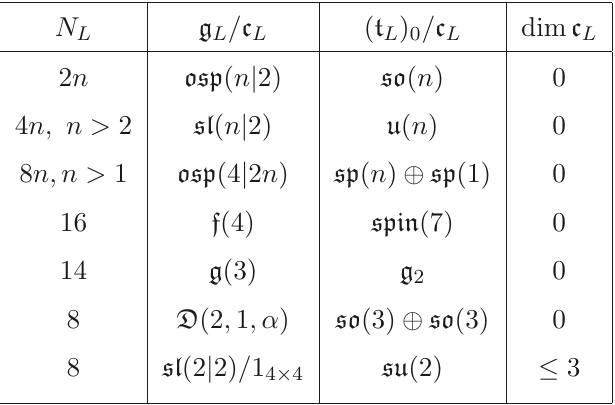
Table 1 . AdS 3 Killing superalgebras in type II and